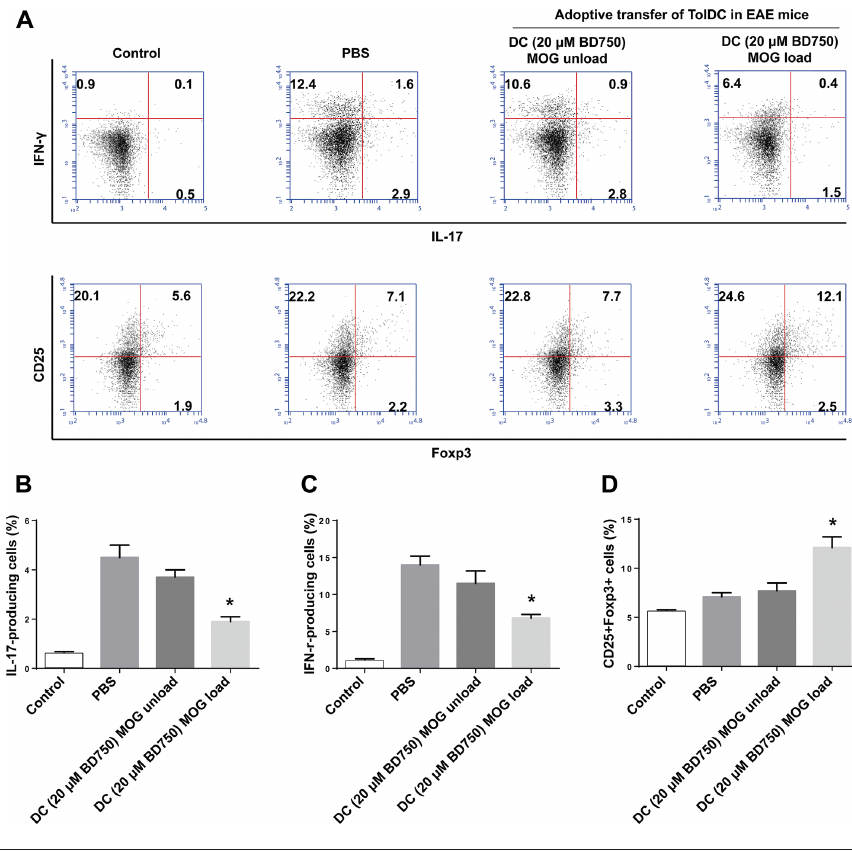
Figure 7. Adoptive transfer of BD750-treated DC decreases the proportion of splenic Th1 and Th17 cells and Tregs in EAE mice. On d 22 post the first PTX injection, some mice from each group were euthanized and their splenic T cells were stained with anti-CD4/ anti-CD25, intracellularly stained with anti-IL-17A, anti-IFN- γ or anti-Foxp3. The percentages of splenic Th1 and Th17 cells and Tregs were determined by flow cytometry. Data are representative FACS charts or expressed as the mean ± SEM of each group of mice (n = 8 per group). (A) Flow cytometry analysis. (B) Quantitative analysis of the percentages of Th1 and Th17 cells and Tregs. * P < 0.05, ** P < 0.01 versus the PBS